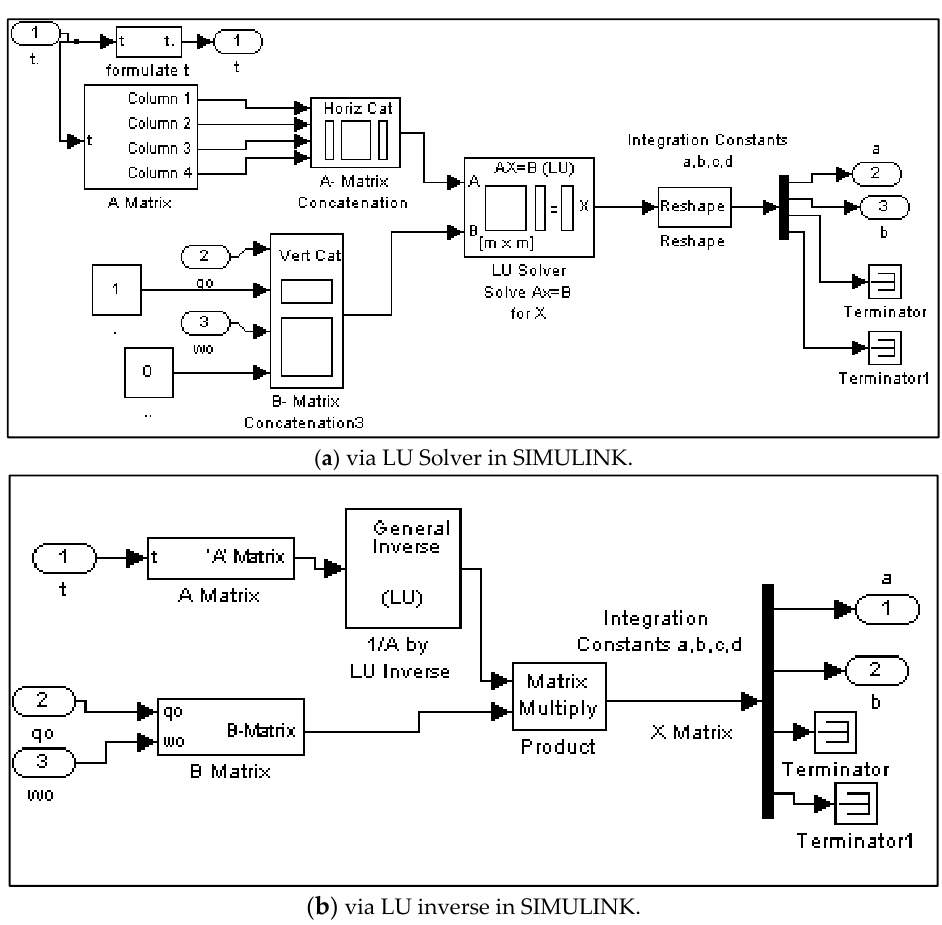
Figure 3. SIMULINK systems to solve for constants of integration in real ‐ time online.